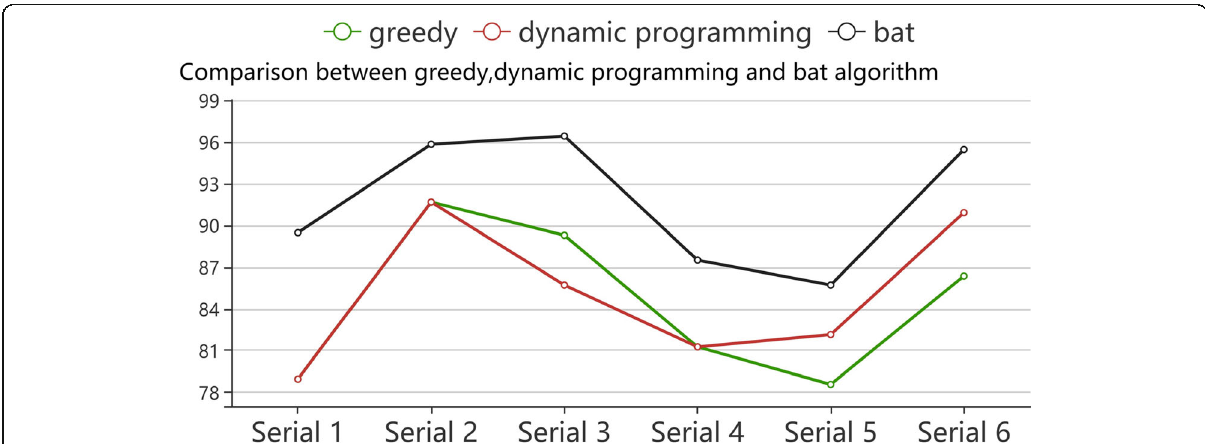
Fig. 2 Comparison of results between greedy, dynamic programming, and bat algorithm — line chart. In Fig. 2, the vertical axis represents the ratio of idle network occpied by request and the horizontal axis represents multiple sets of data. The maximum time of request that can be placed in an idle network sequence, the mapping sequence based on greedy algorithm, dynamic programming and discrete bat algorithm, and the ratio of idle network occpied by request are listed in Tables 2 and 3. From the figure, we can infer that the bat algorithm is modified by binary code and sigmoid function which makes it suitable for discrete simplified model. Compared with the other two algorithms, the algorithm has achieved good